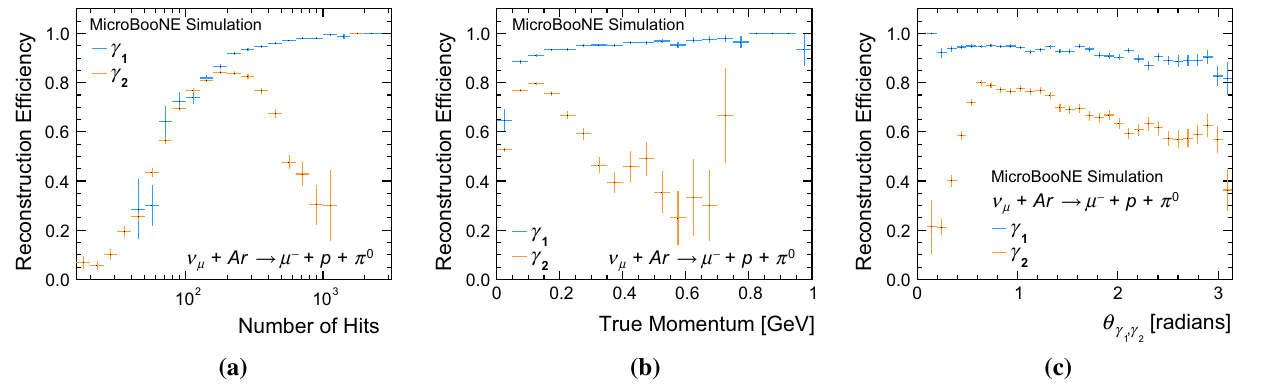
Fig. 18 Reconstruction efficiencies for the target photons ( γ 1 is the photon with the largest number of true hits, γ 2 has fewer true hits) in simulated BNB CC ν μ interactions with resonant neutral-pion produc-